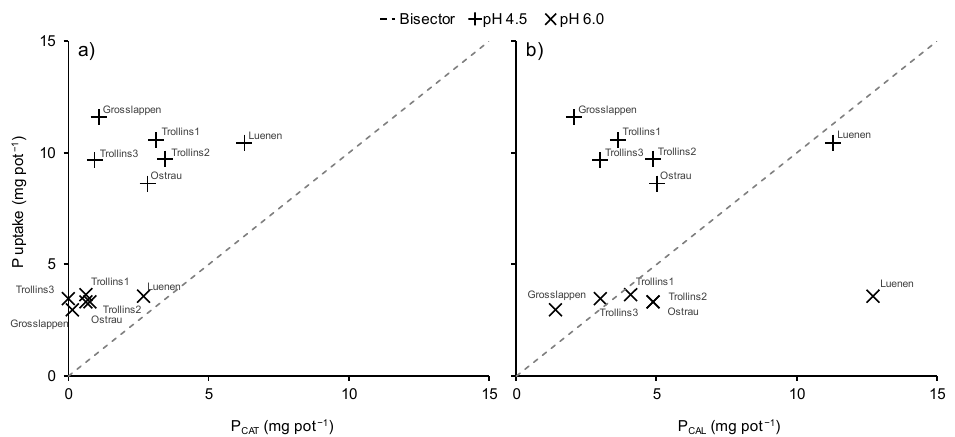
Figure 5. Relationship of phosphorus (P) uptake of marigold plants four weeks after fertilization with different sewage sludge ashes (Trollins1, Trollins2, Trollins3, Ostrau, Luenen, Grosslappen) and cultivation in growing media of contrasting pH to P CAT ( a ) and P CAL ( b ) at the trial start in the growing medium.